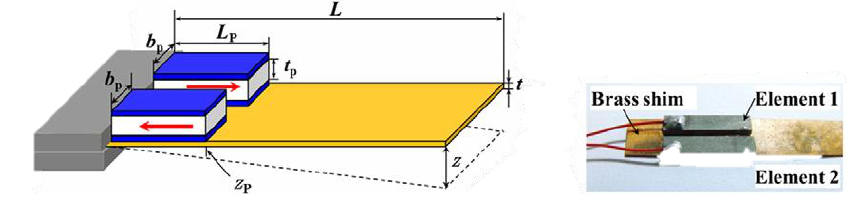
Figure 17. Schematic representation and picture of the series connected harvester of Zhao and colleagues [77] ( © IOP Publishing. Reproduced by permission of IOP